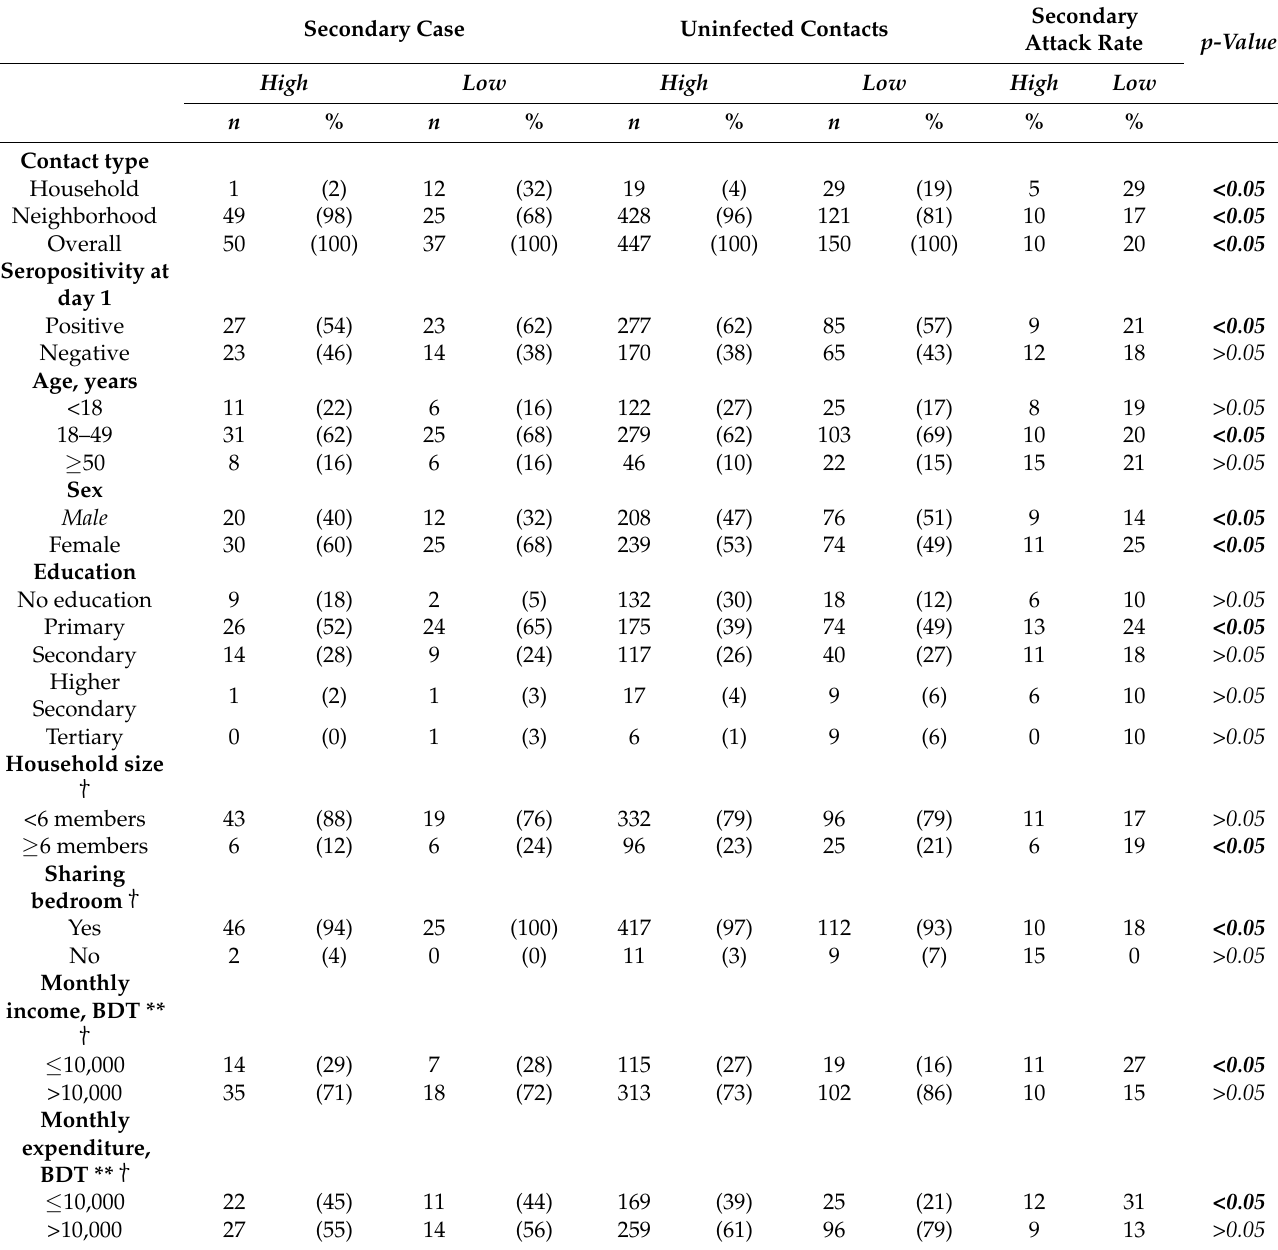
Table 2. Secondary attack rate (SAR) in high-density and low-density areas in Dhaka city. Secondary Case Uninfected Contacts Secondary Attack Rate p-Value High